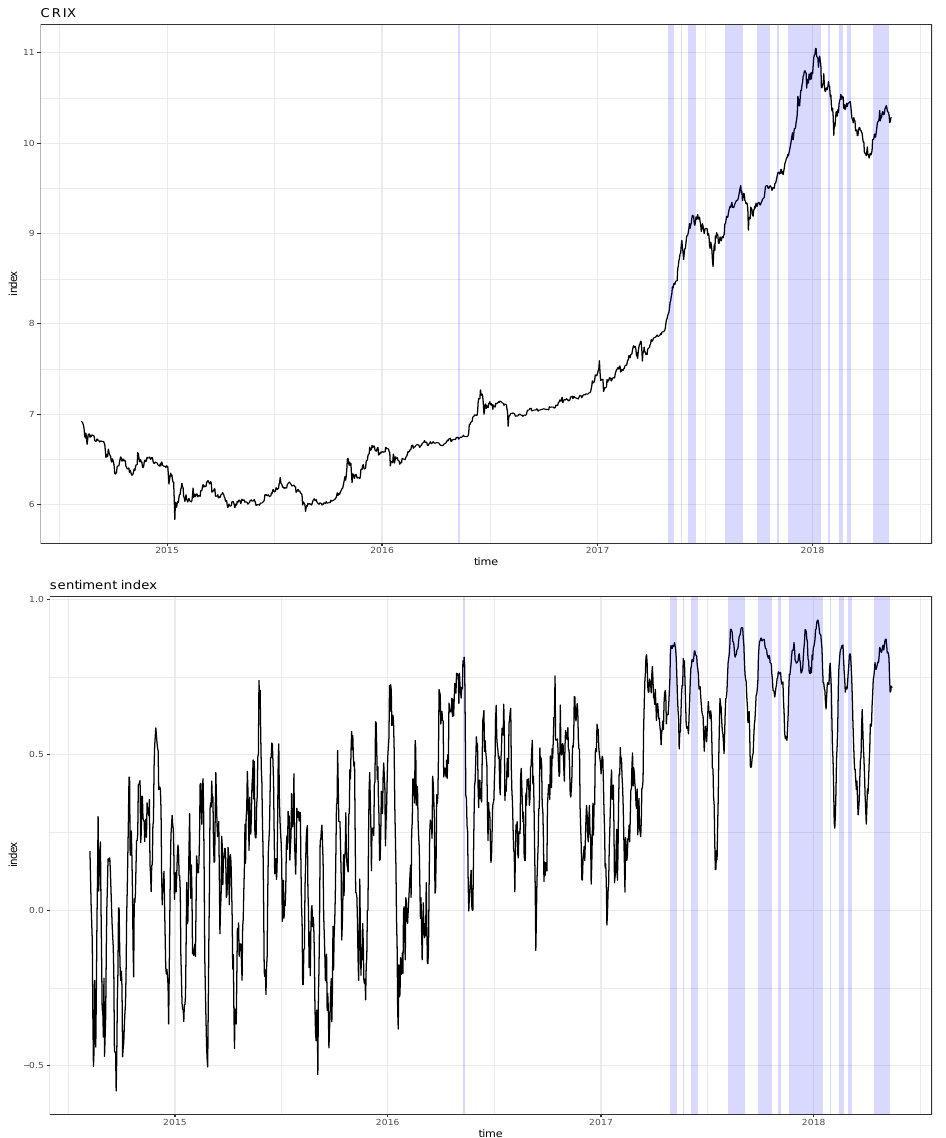
Figure 2: Log CRIX (upper panel) and sentiment index (lower panel). The shaded areas correspond Figure 2. Log CRIX ( upper panel ) and sentiment index (lower panel ). The shaded areas correspond to the estimated bubble to the estimated bubble periods.